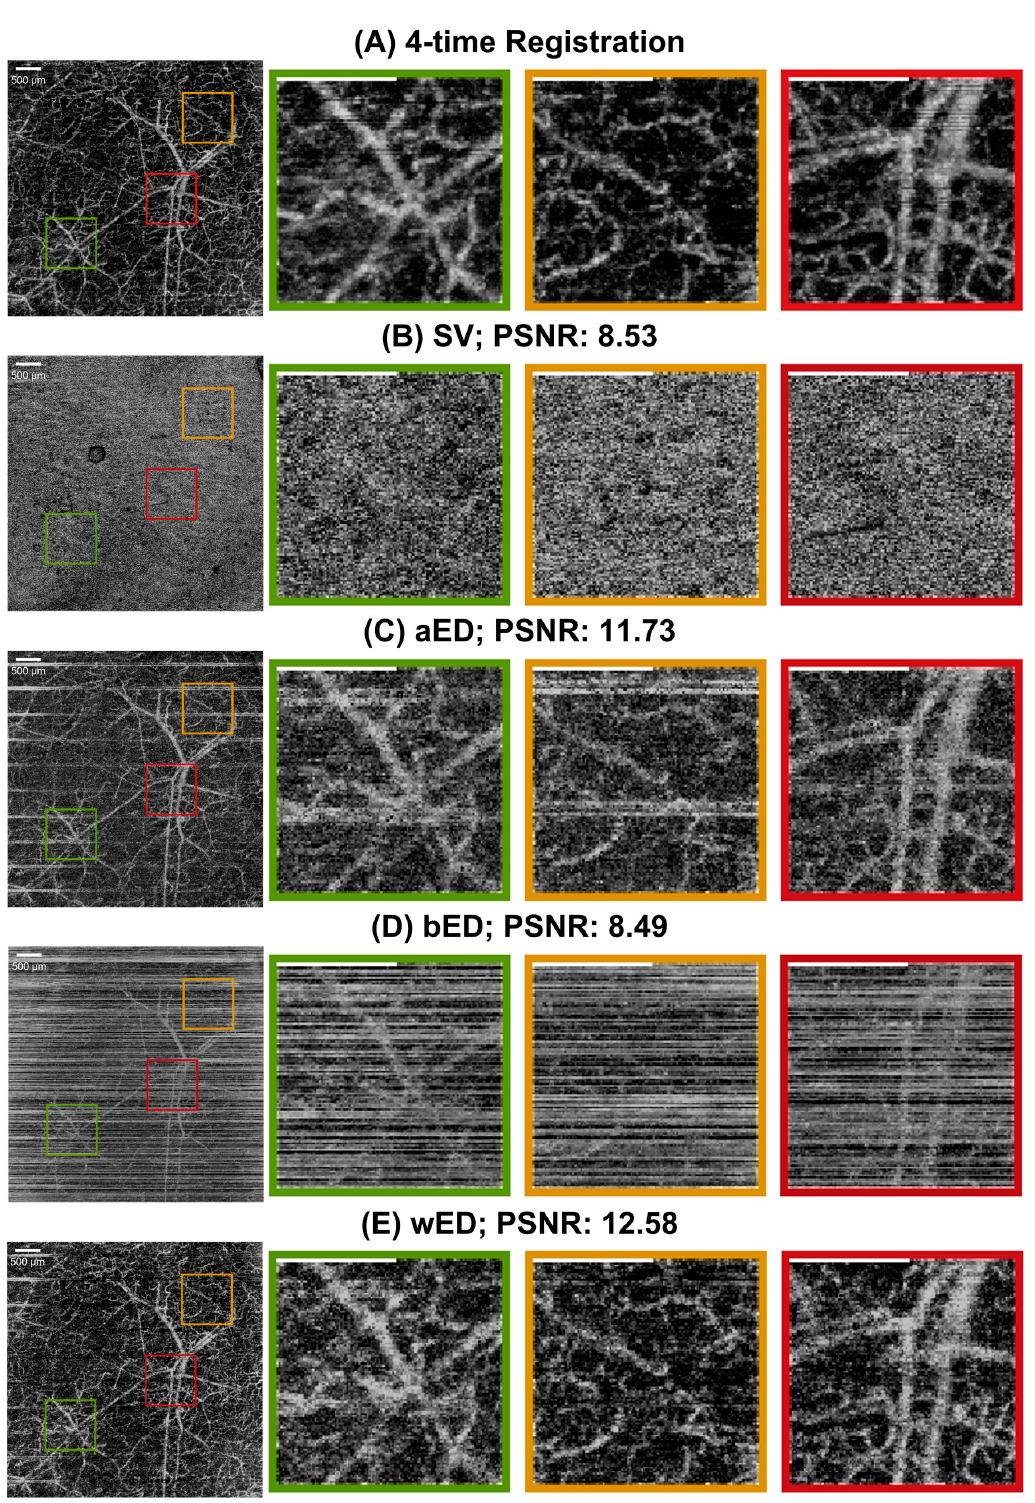
Figure A1. The comparisons of en face results from maximum intensity projection. ( A ) Registration from 4-time acquisitions; ( B ) SV; ( C ) aED; ( D ) bED; ( E ) wED. (All scale bars represent 500 μ m); SV: Speckle Variance; aED: A-scan eigen-decomposition; bED: B-scan eigen-decomposition; wED: win- dowed eigen-decomposition.